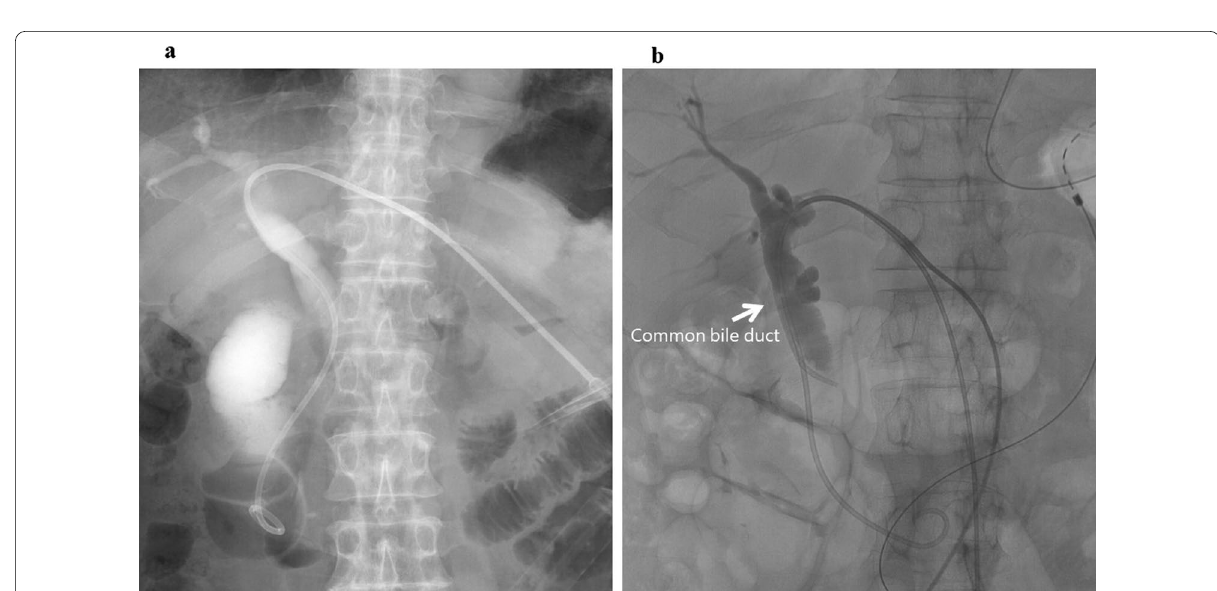
Fig. 3 The images of the percutaneous transhepatic cholangial drainage. a An image of 1st PTCD. An 8.5-French pigtail catheter was inserted via the lateral inferior branch of the intrahepatic bile duct, with the catheter tip placed in the duodenum. b An image of 2nd PTCD. 8.5-French multiside hole pigtail catheter and 7-French multiside hole straight catheter were inserted into the duodenum and common bile duct,